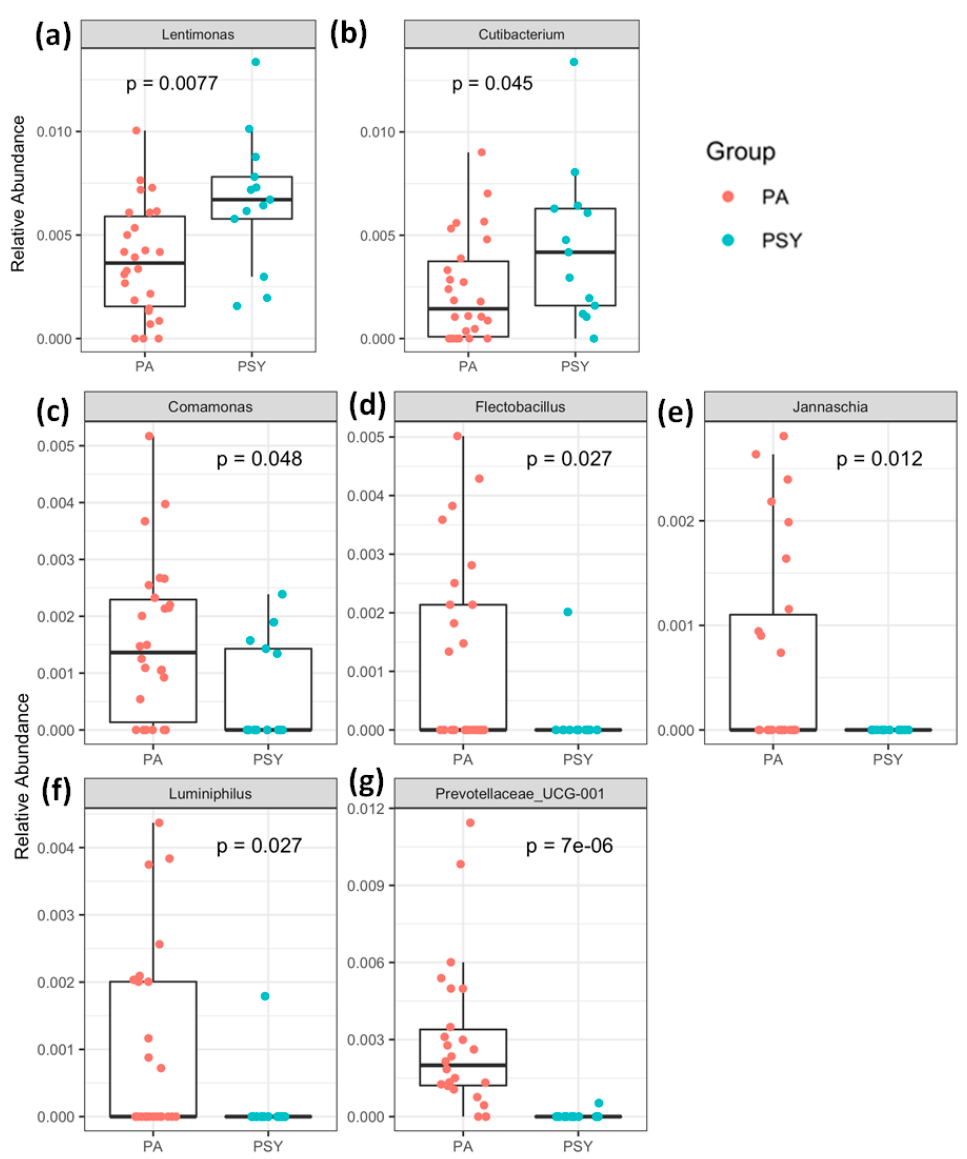
Figure 3. Dysbiosis of the nasal microbiota in COVID-19 symptomatic patients. ( a ) Lentimonas ( p value = 0.007) and ( b ) Cutibacterium ( p value = 0.045) bacteria elevated at the genus level, whereas ( c ) Comamonas ( p value = 0.048), ( d ) Flectobacillus ( p value = 0.027), ( e ) Jannaschia ( p value = 0.012), ( f ) Luminiphilus ( p value = 0.027), and ( g ) Prevotellaceae ( p value = 7 × 10 − 6 ) show significantly low abundance in PSA compared to PA. Within each box, horizontal black lines denote median values; boxes extend from the 25th to the 75th percentile of each group’s distribution of values; vertical extending lines denote adjacent values (i.e., the most extreme values within 1.5 interquartile range of the 25th and 75th percentile of each group); dots denote observations outside the range of adjacent values; and p -values were calculated using multiple-group Kruskal–Wallis test and two-group Wilcoxon test.